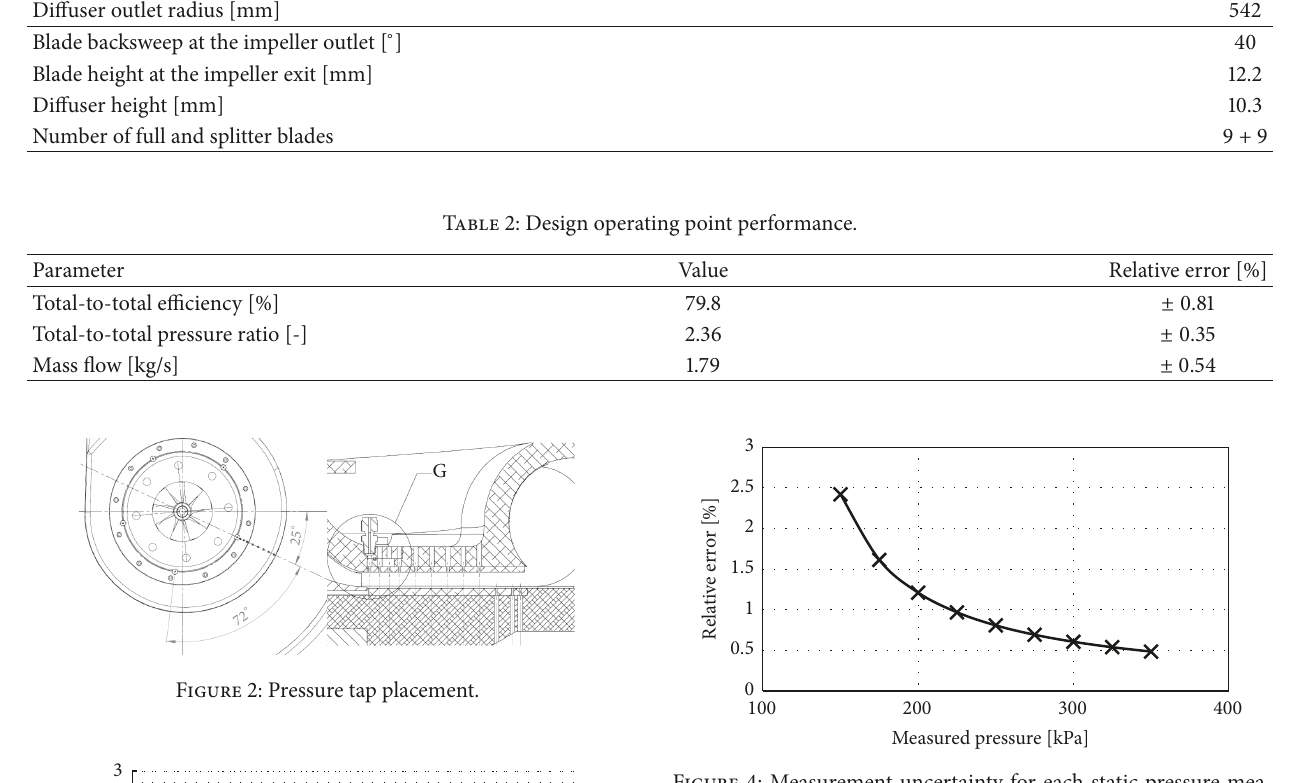
Figure 4: Measurement uncertainty for each static pressure mea-